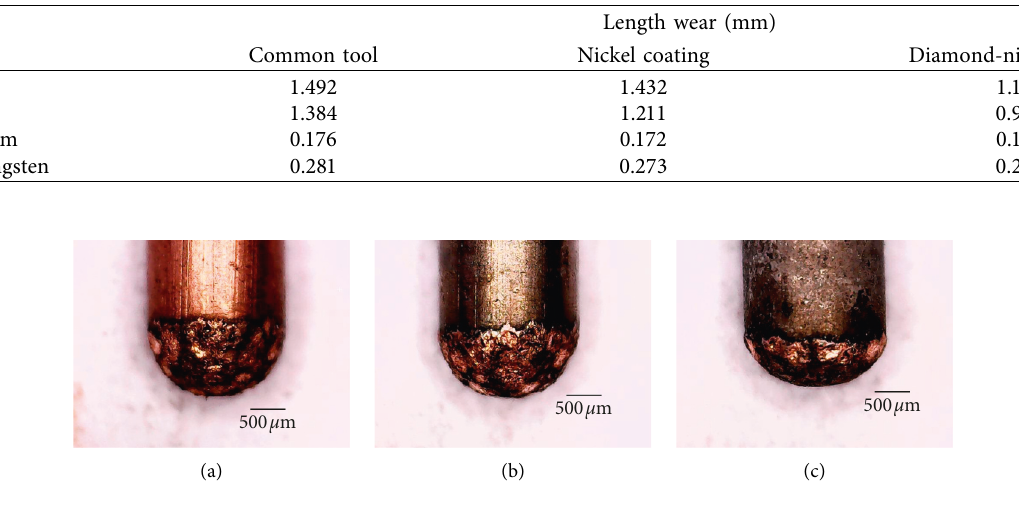
Figure 7: Shape change of copper-based composite tools. (a) Common tool. (b) Nickel-coated tool. (c) Diamond-nickel-coated tool.